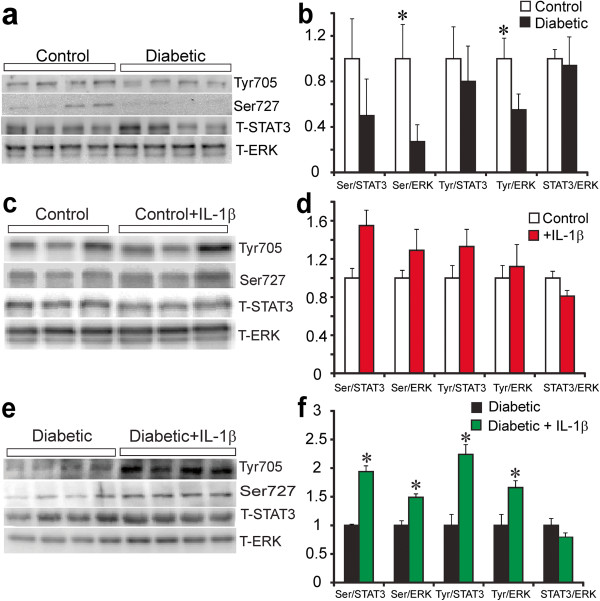
STAT3 phosphorylation is impaired in DRG in diabetes and enhanced by IL-1β in neuron cultures. In (a) is shown Western blot of DRG samples from control and 5 month STZ-diabetic mice. In (b) expression levels are indicated and are presented relative to T-ERK or T-STAT3 and are means ± SEM (n = 3–4 mice) *P < 0.05 vs control. In (c and e), are shown representative Western blots of DRG from normal or diabetic rats cultured for 1 day at low dose of neurotrophic growth factors and stimulated for 30 minutes with IL-1β at (10 ng/ml). In (d and f) are bar charts showing levels of phosphorylation of STAT3 on Ser-727 (Ser) or Tyr-705 (Tyr) presented relative to total ERK or total STAT3. *P < 0.05 vs untreated. Values are mean ± SEM, n = 4 (two-way ANOVA with Bonferroni’s test). Bar charts b, d, and e also show total STAT3 levels relative to T-ERK.